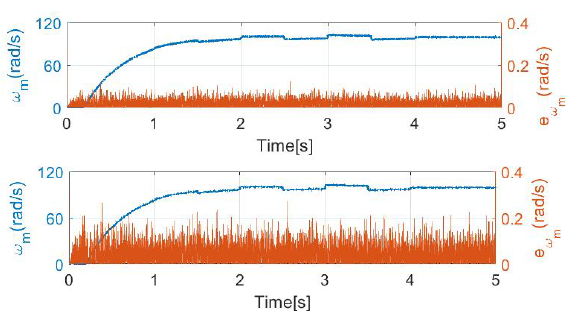
Figure 6. Speed control with noise signals with a variance of 0.001 ( upper ) and 0.005 ( bottom ). Even if the error scales up with the noise signal, the speed controller remains stable and reliable. The signals i ds and i qs associated with Figure 6 can be seen in Figure 7. Investigating the second case, where noise has been applied to the feedback speed sig- nal, with the amplitude of 20 times as shown in Figure 5. Other parameters are unchanged; the results can be seen in Figures 8 and 9.